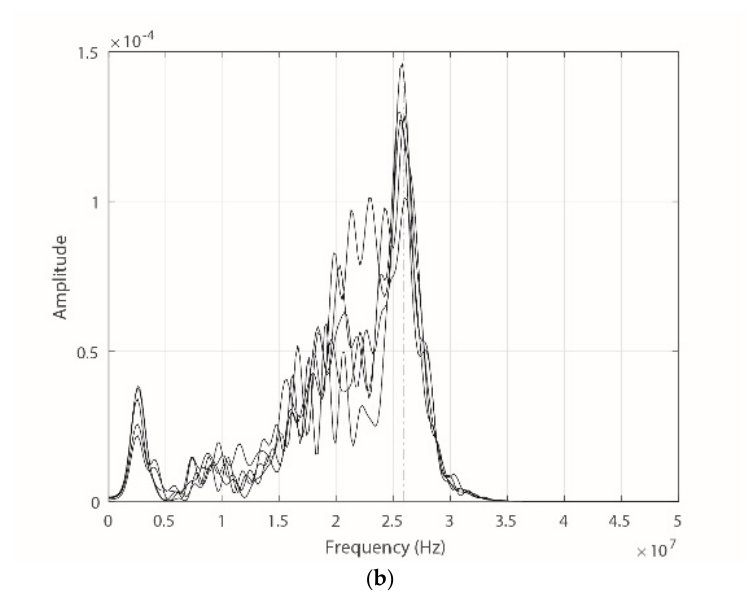
Figure 16. FFT of the signals captured by the ILS. ( a ) For 2 mm; and ( b ) for 5 mm.